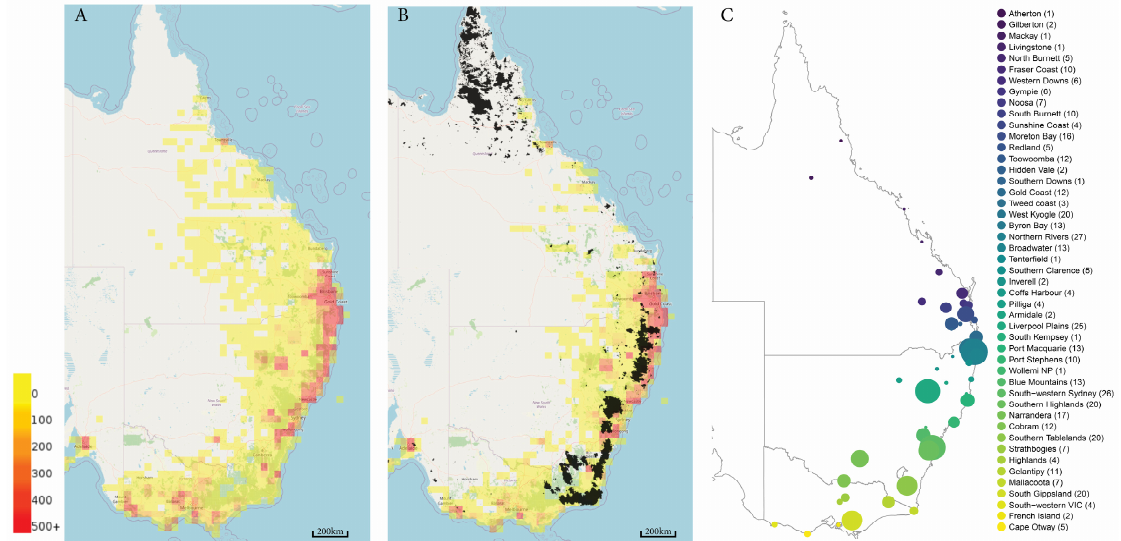
Figure 1. ( A ) Koala density grid from spatially valid records between 26/1/1788 and 31/12/2022 (Atlas of Living Australia). ( B ) Koala density grid from spatially valid records for the time period of samples collected for this study (1/1/2004 to 31/12/2022; Atlas of Living Australia). The black regions are the national indicative aggregated fire extent 2019–2020 (v20200324; Atlas of Living Australia). ( C ) Location of the wild samples collected as part of the Koala Genome Survey, the size of the dot is indicative of sample size, with the largest sample size being N = 20. Numbers in brackets after the location name are the sample size for that